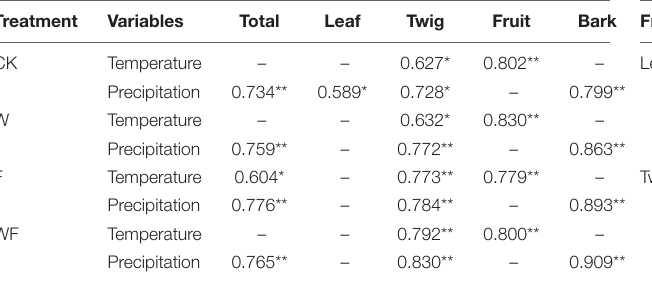
TABLE 3 | Decomposition equations of Olson negative exponential decay model of leaf and twig for all